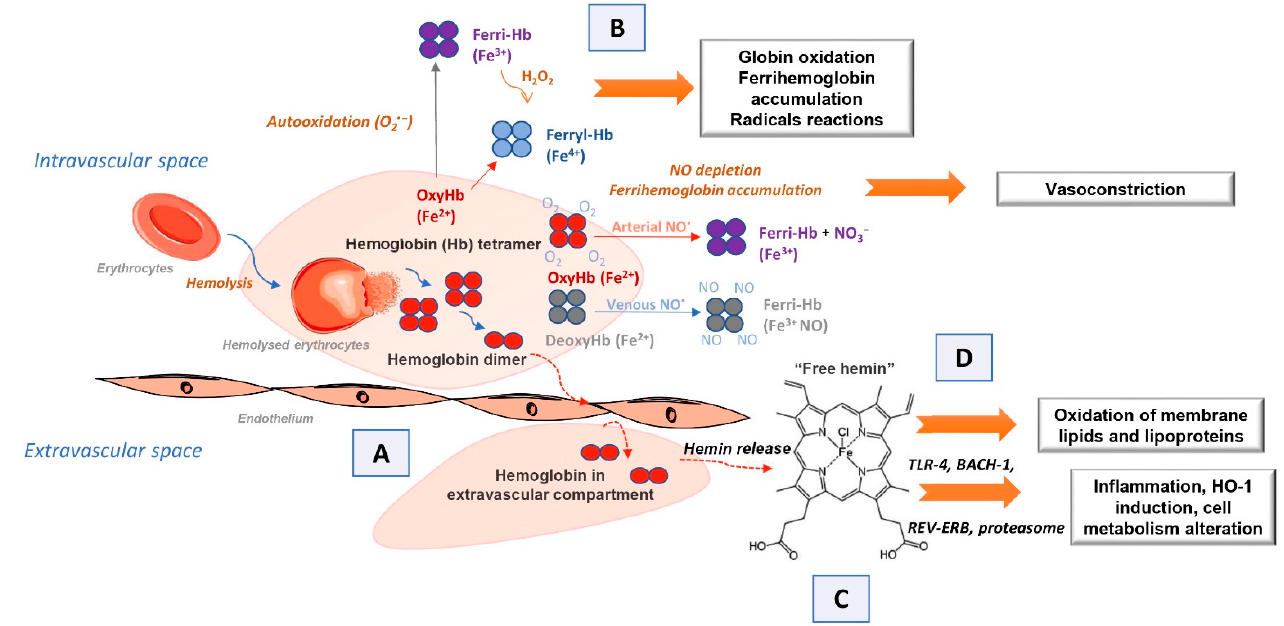
Figure 1. Scheme illustrating the mechanisms of action of endogenous extracellular hemoglobin: ( A ) extravascular translocation of hemoglobin, ( B ) prooxidative reactivity of hemoglobin in plasma or within tissues after extravasation, ( C ) release of hemin from Hb-Fe 3+ as the main product of oxidative reactions and ( D ) hemin induced changes in cell activation, gene expression, and metabolism.